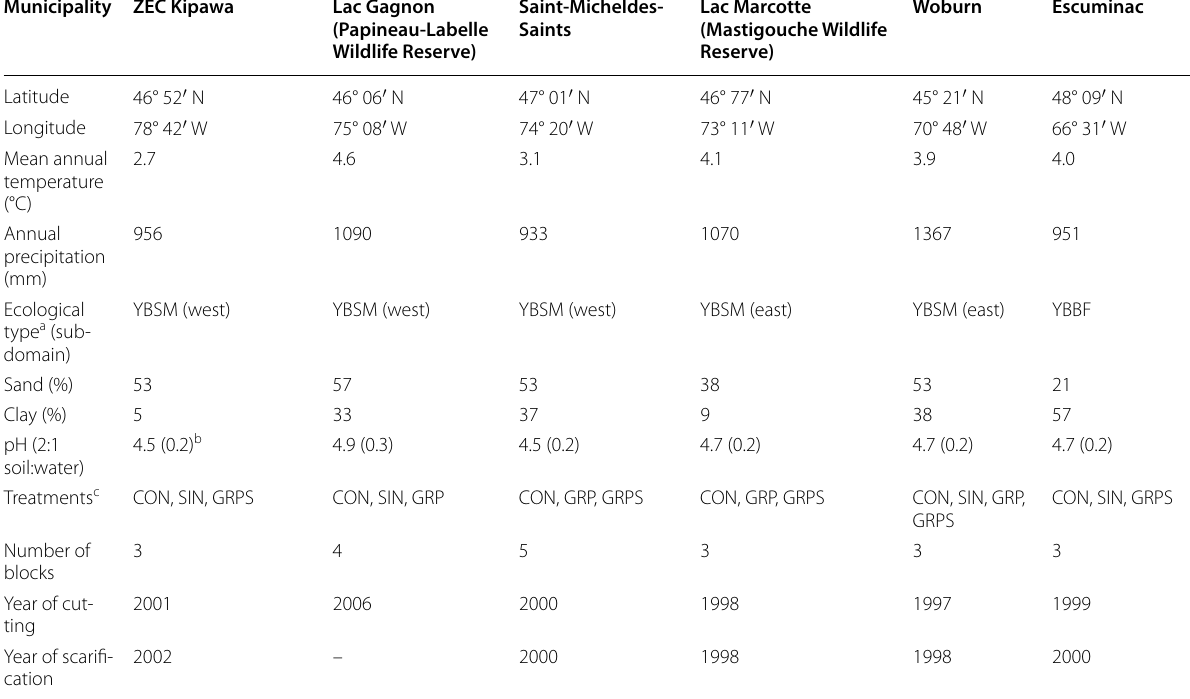
Table 6 Environmental, ecological and edaphic characteristics of the study sites that were located in southern Quebec,